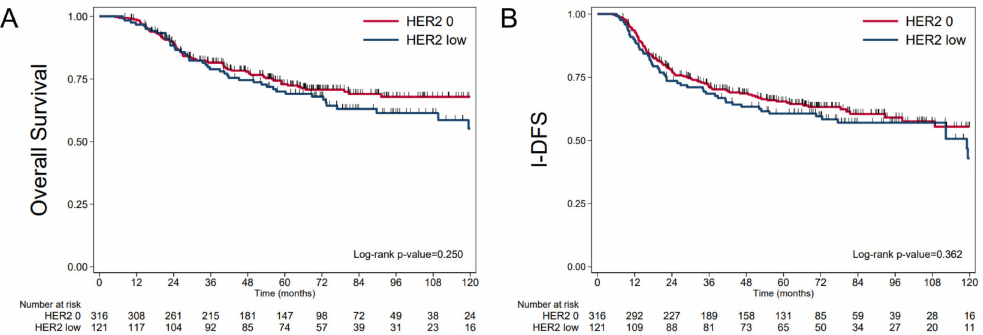
Figure 2. Outcomes data according to HER2 status (HER2-low versus HER-0). ( A ) OS, ( B )